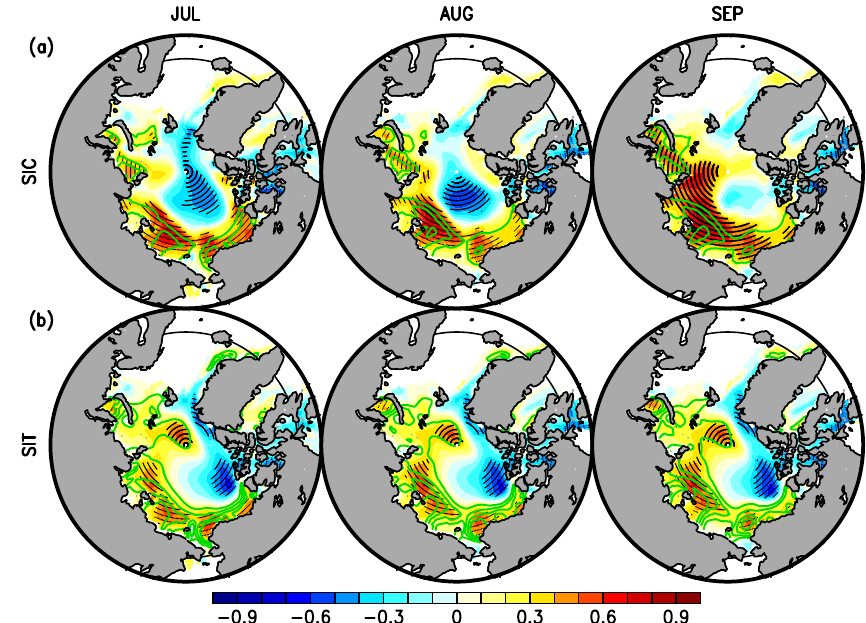
Figure 5. Lagged correlation (colours) and regression (contours) coefficients between the September SIE AO anomaly ( × 10 6 km 2 ) and (a) SIC anomaly (%) and (b) SIT anomaly (cm), based on the hindcasts started from 1 July. Contours are drawn at intervals of 5 (%) from 5 to 20 and at intervals of 10 (cm) from 10 to 40 for the SIC and SIT anomalies, respectively. Stippling indicates regions with statistically significant correlation coefficients at the 95% confidence level. White shading indicates areas where sea ice does not exist. A latitude circle of 65 ◦ N is also indicated by a thin solid